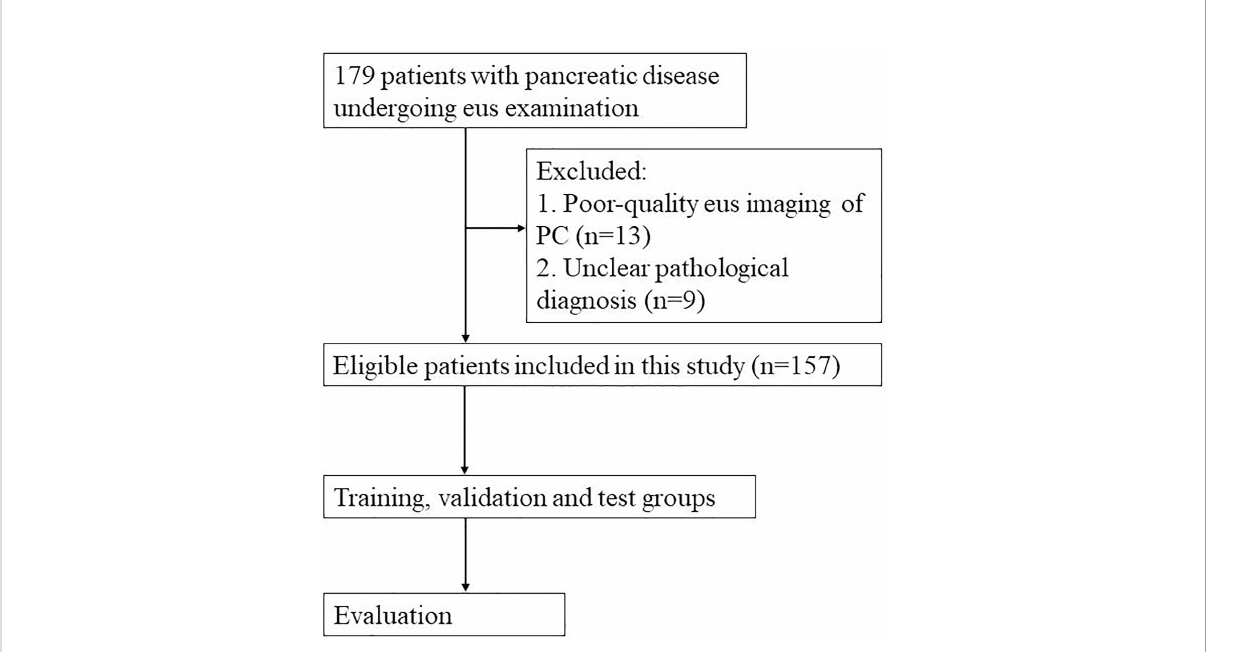
FIGURE 1 Flowchart depicting the selection process for this